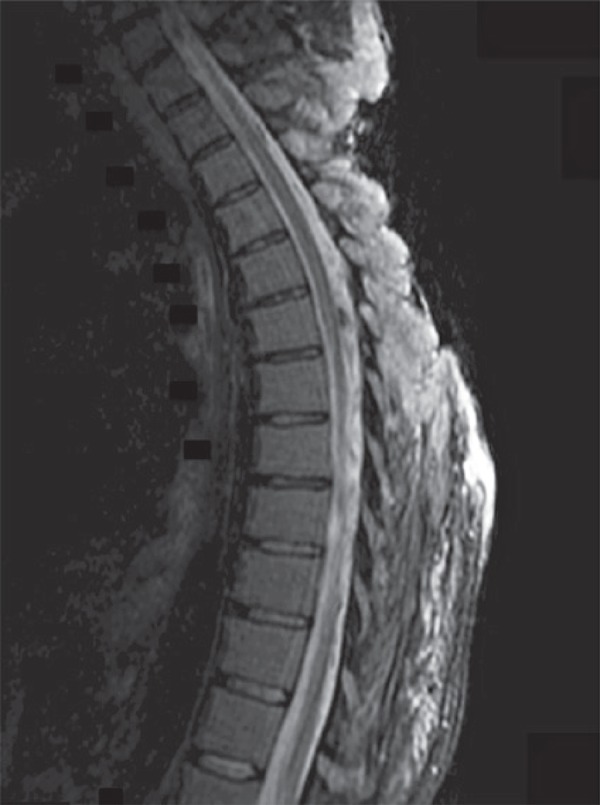
Visão da linha média sagital da espinha, por meio de ressonância magnética, demostrando ausência do envolvimento do cordão espinhal